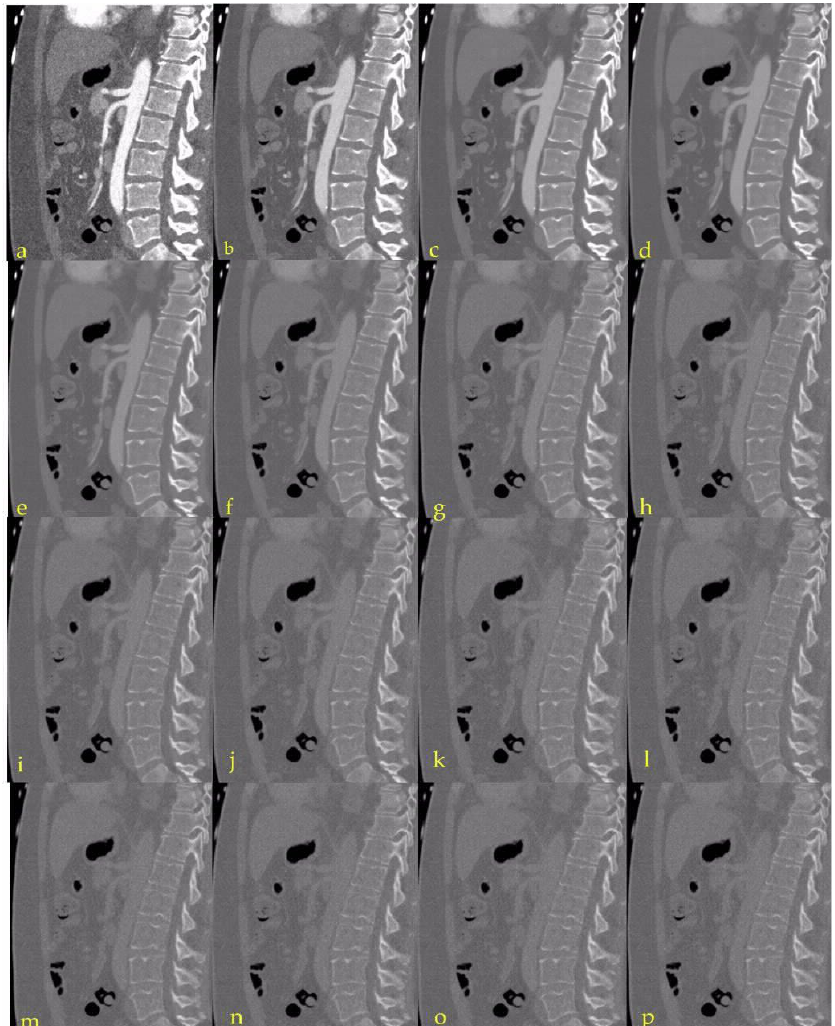
Figure 1. Sagittal images with focus on the abdominal aorta at different virtual monoenergetic levels to visualize the changes: ( a ) 40 keV; ( b ) 50 kV; ( c ) 60 keV; ( d ) 70 keV; ( e ) 80 keV; ( f ) 90 keV; ( g ) 100 keV; ( h ) 110 keV; ( i ) 120 keV; ( j ) 130 keV; ( k ) 140 keV; ( l ) 150 keV; ( m ) 160 kV; ( n ) 170 keV; ( o ) 180 keV; ( p ) 190